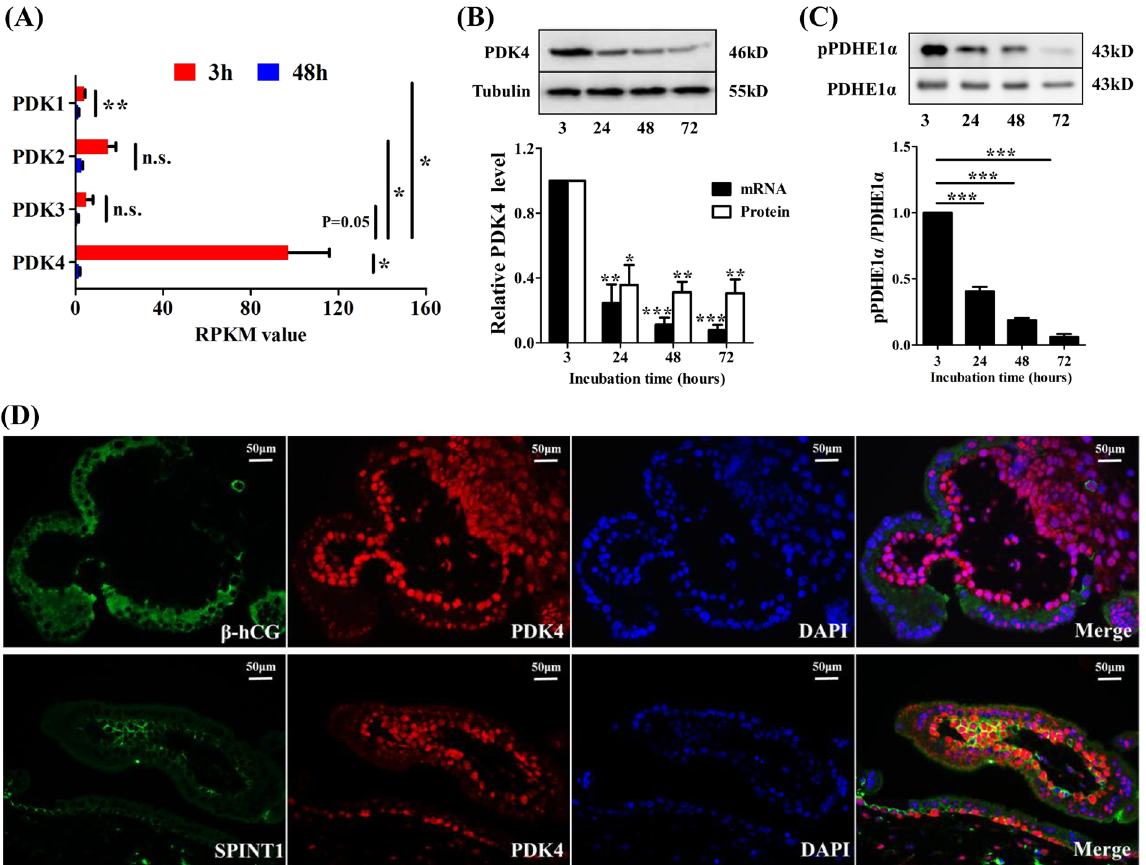
Figure 2. PDK4 expression during syncytialization of human placental trophoblasts. ( A ) Changes of the RPKM values for PDK family members in trophoblasts before (red column, 3 hours) and after (blue column, 48 hours) syncytialization. ( B ) Changes in PDK4 mRNA (black column, n = 4) and protein (white column, n = 4) abundance during syncytialization. ( C ) Changes in the phosphorylation of PDHE1 α during syncytialization n = 4. ( D ) Representative images showing intense staining of PDK4 (red) in the cytotrophoblast layer and weak staining of PDK4 in the syncytial layer of human chorionic villi at early gestation. The syncytial and cytotrophoblast layers were labeled with β -hCG (green) and SPINT1 (green) respectively. Nuclei were counterstained with DAPI (blue). n = 3; * P < 0.05; ** P < 0.01; *** P < 0.001 against 3 hours; n.s., not